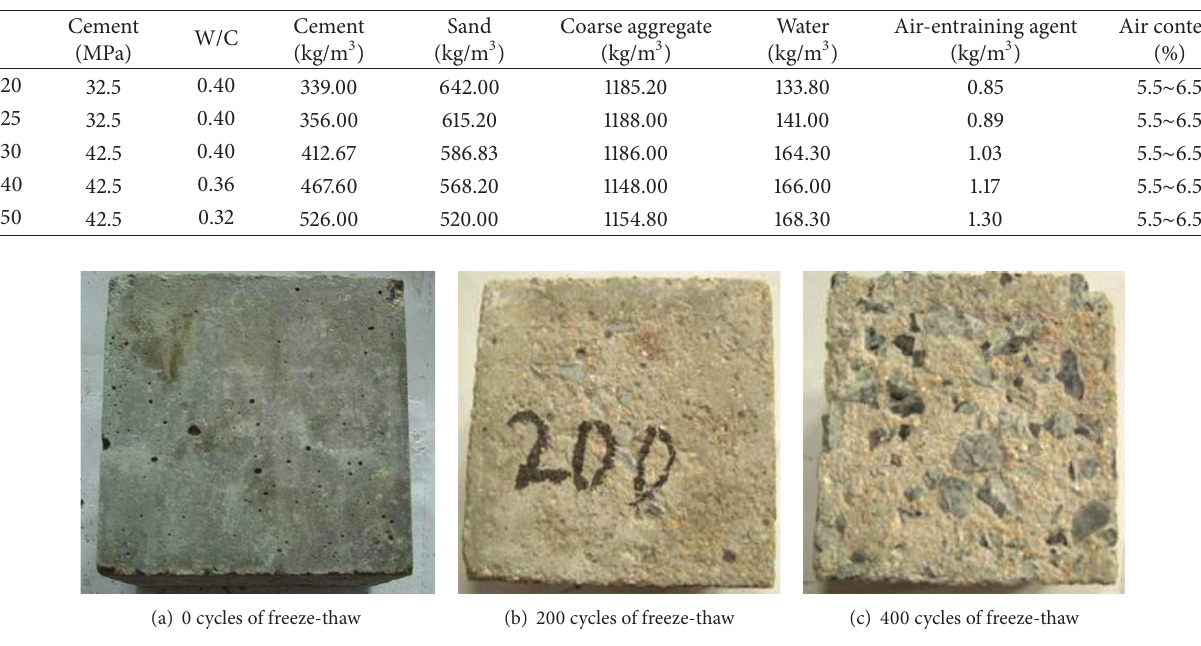
Table 1: The mix proportion of air-entrained concrete in per cubic meter.